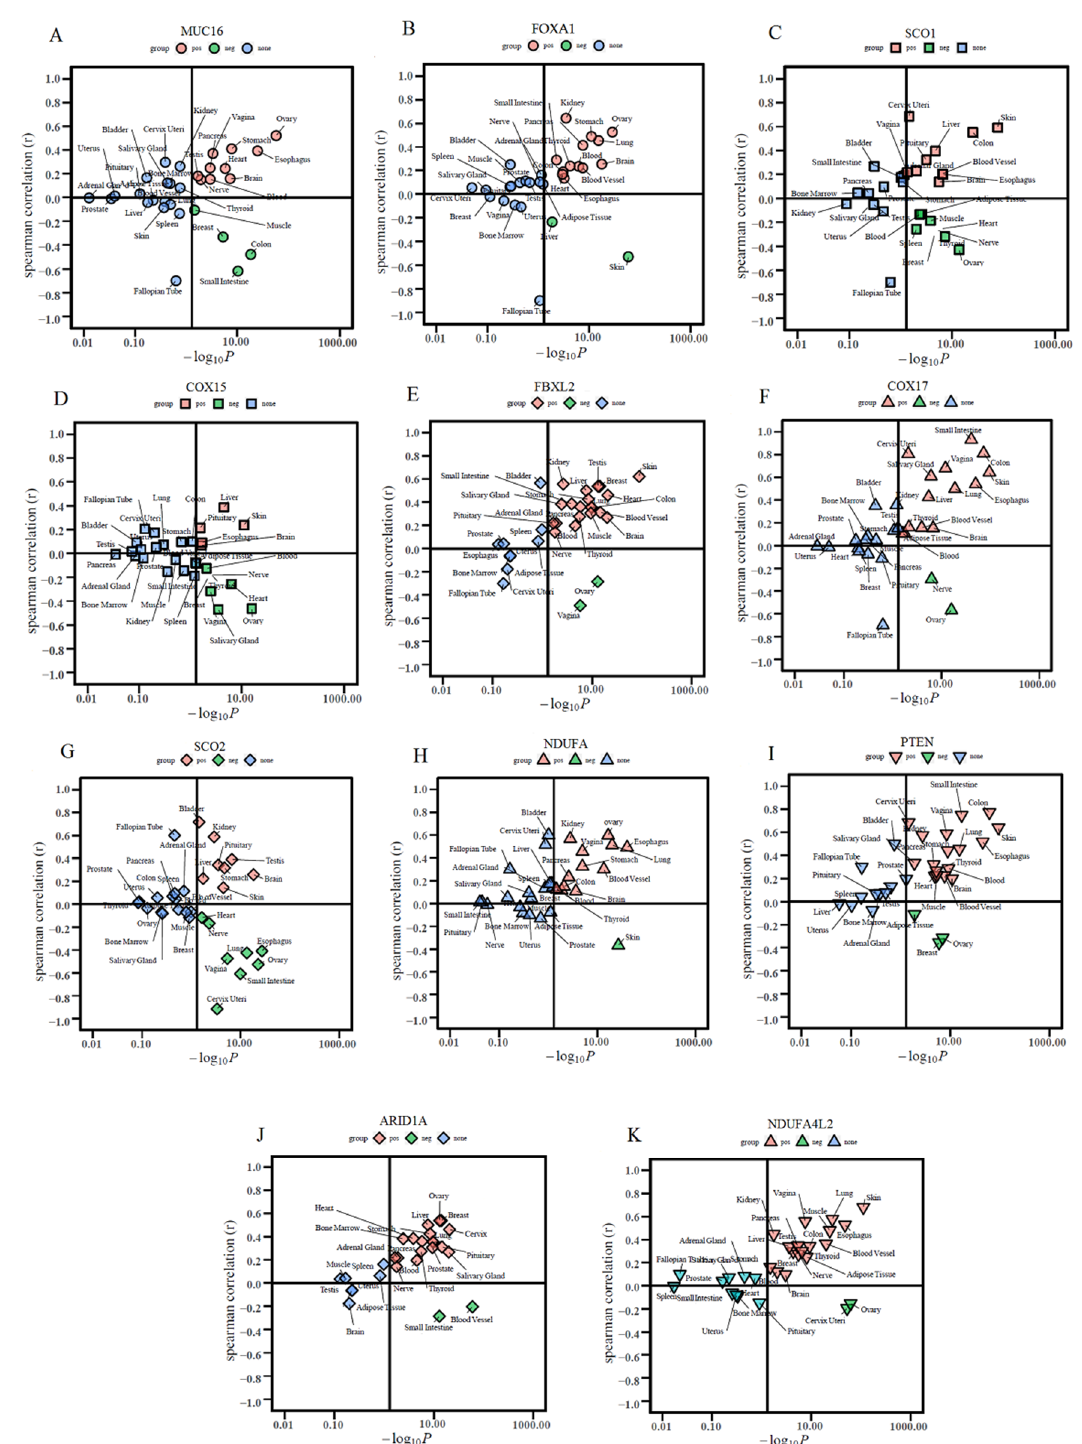
Figure 7. Spearman correlation analysis of hub genes in EOC and multiple normal tissues (a–k). Rows represented “-Log10P”, and the vertical line in the middle of the graph indicates p = 0.05. Columns represent the correlation between hub genes and EOC, and “0” value axis indicates no correlation between hub genes and EOC. The upper part of the “0” value axis indicates a negative correlation, and the lower part indicates a positive correlation. Red shape represented positive correlation of the gene with different cancers. Green shape represented negative correlation of the gene with different cancers. Blue shape represented none correlation of the gene with different